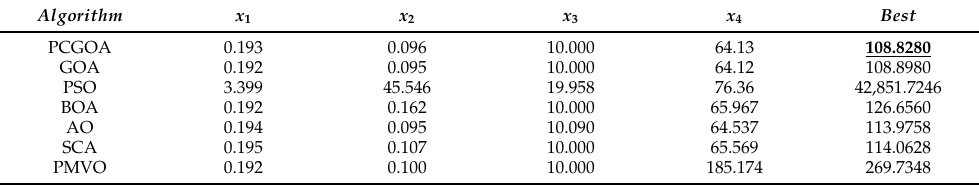
Table 5. Comparison results of each algorithm for the pressure vessel design problem. Algorithm x